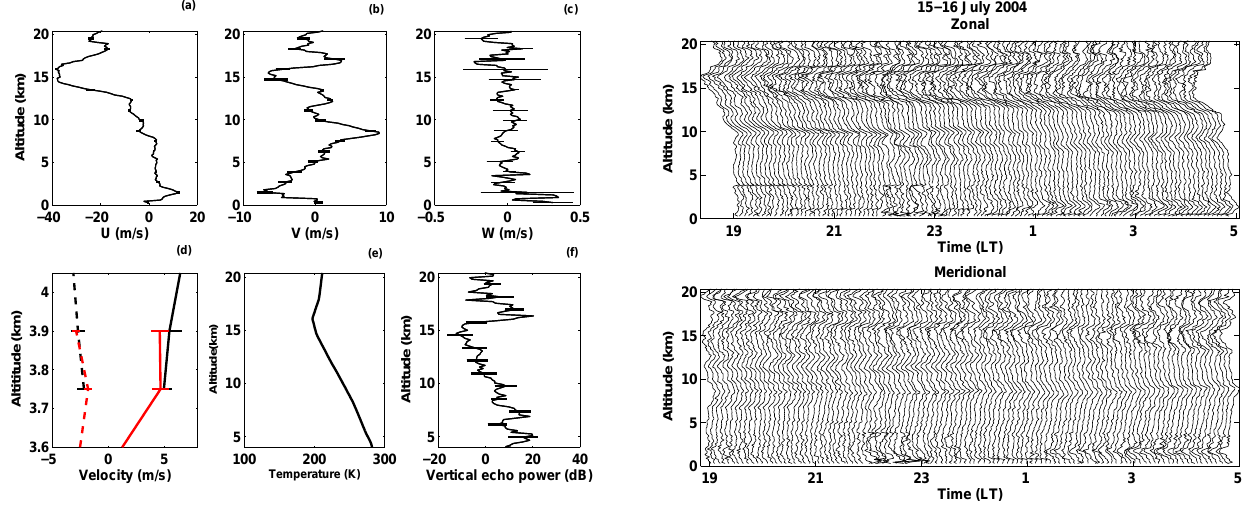
Fig. 2. Profiles of zonal (a) and meridional (b) winds shifted by 5m/s, measured by MST radar and LAWP averaged over 5min (2 profiles) between 19:00 and